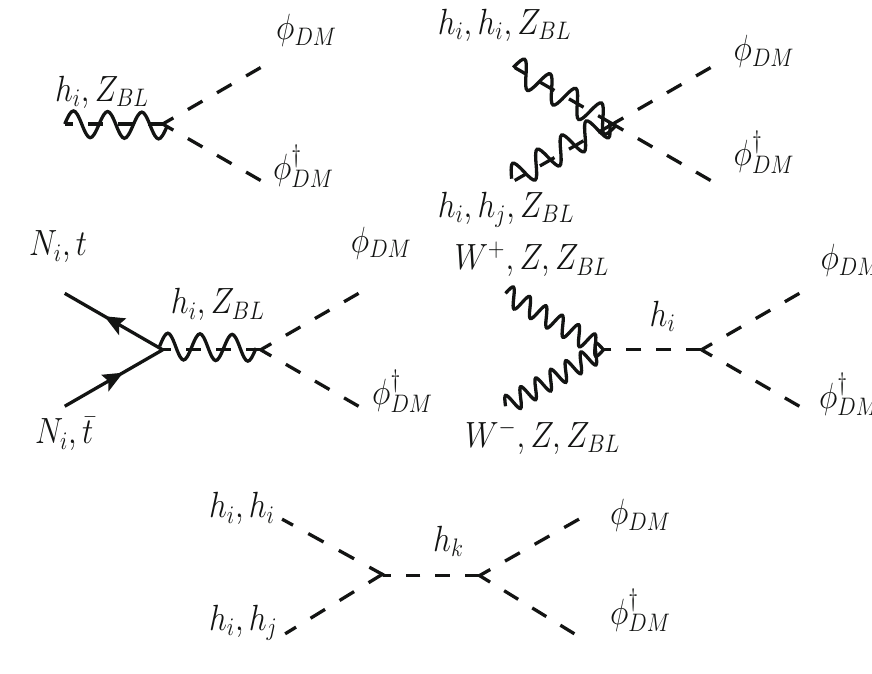
Fig. 7 Production processes of φ DM from both SM as well as BSM particles after